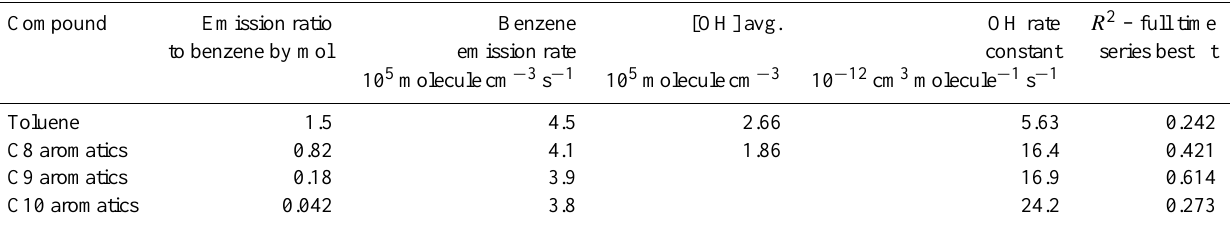
Table 2. Primary compound results. Compound